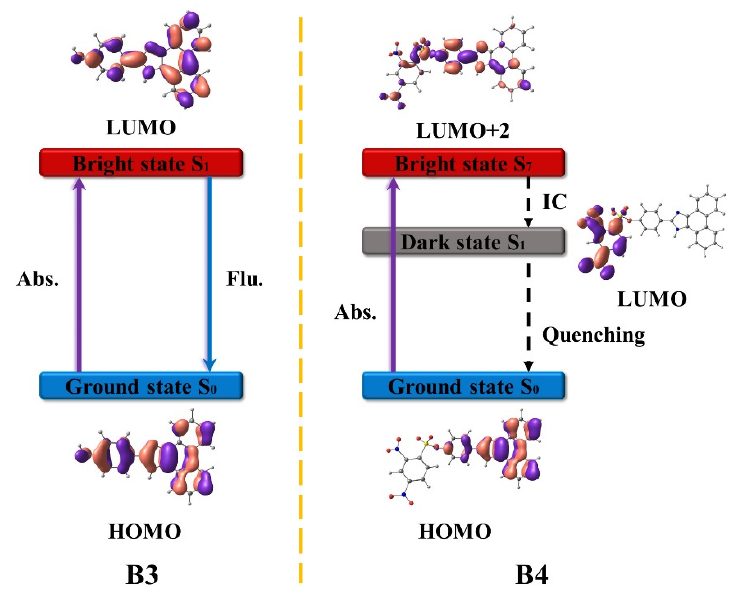
Figure 5. Scheme of the different sensing mechanisms and relevant frontier molecular orbitals B3 and B4.